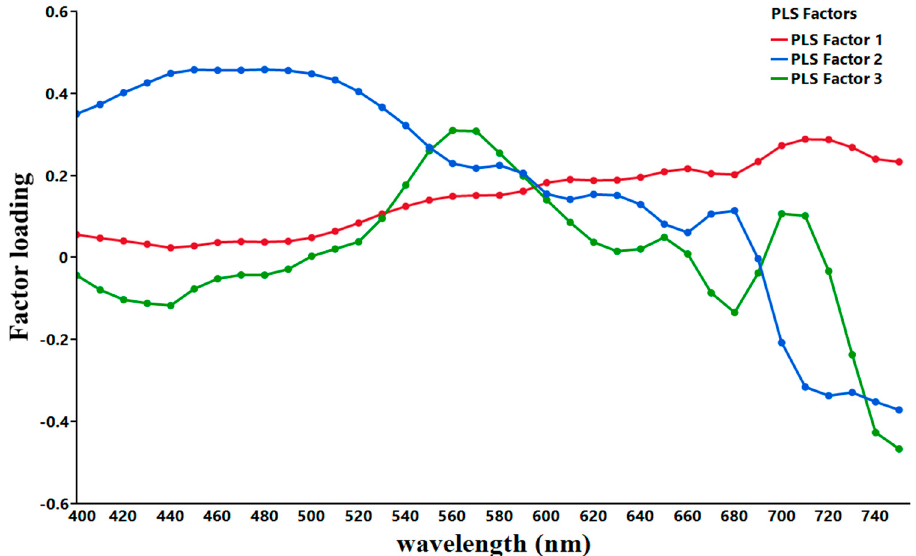
Figure 4. Three primary PLS component loadings.